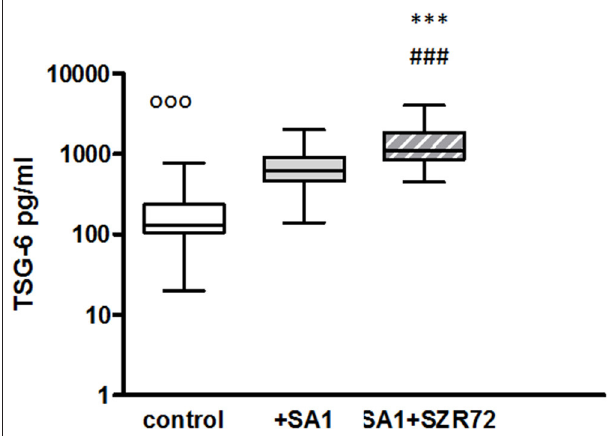
FIGURE 4 | The effect of KYNA analog, SZR72 on TSG-6 production in human whole blood cells of normal donors stimulated by heat-inactivated Staphylococcus aureus. Ethylenediaminetetraacetic acid (EDTA)-anticoagulated blood samples 1–1ml from each of 50 healthy donors were incubated with SZR72 at a concentration of 500 µ m for 30min prior to the addition of heat-inactivated Staphylococcus aureus (10 7 /ml). The concentrations of TSG-6 in the plasma were determined after an 18 h-incubation period. The data are depicted as box and whiskers plots, where the lines inside the boxes denote medians, and the boxes mark the interval between 25 and 75 percentiles, and the whiskers, the maximum and minimum. Significance was determined by the Friedman’s test and Dunn’s post-test. Control vs. SA1, ooo p < 0.001; control vs. SA1 + SZR72, ### p < 0.001; SA1 vs. SA1 + SZR72, *** p <